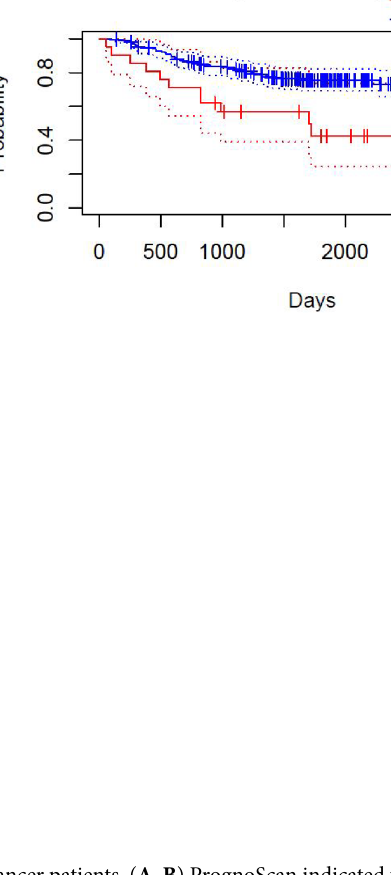
Figure 2. Prognostic values of KDM1A in lung cancer patients. ( A , B ) PrognoScan indicated the roles of KDM1A on OS ( A ) and RFS ( B ) in patients with lung cancer. ( C ) Kaplan–Meier plotter indicated the roles of KDM1A on FP in patients with lung